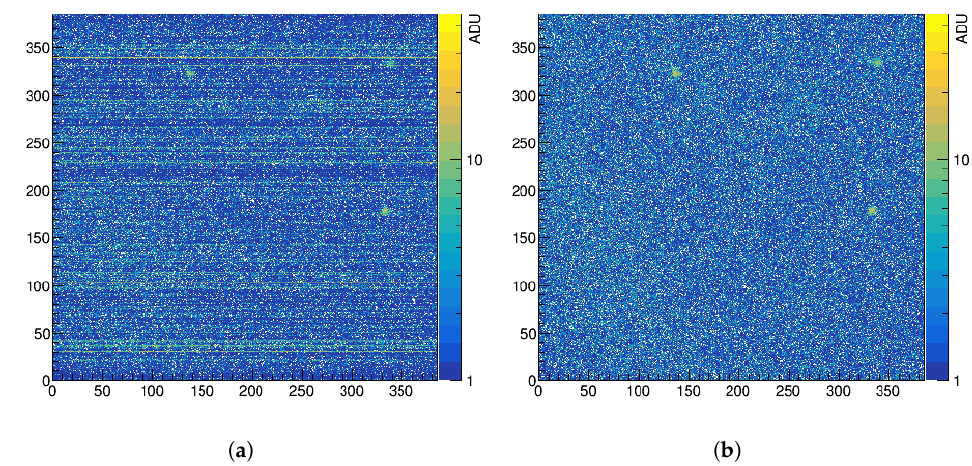
Figure 11. Example of the average of 100 bias subtracted events with event and bias frame taken days apart ( a ) before row correction (demonstrating row CCD artefacts) ( b ) after row correction (demonstration correction of row CCD artefacts). The colour in both plots encodes the ADU value at the position of a pixel, while the horizontal and vertical axis shows the y and x coordinate, respectively.